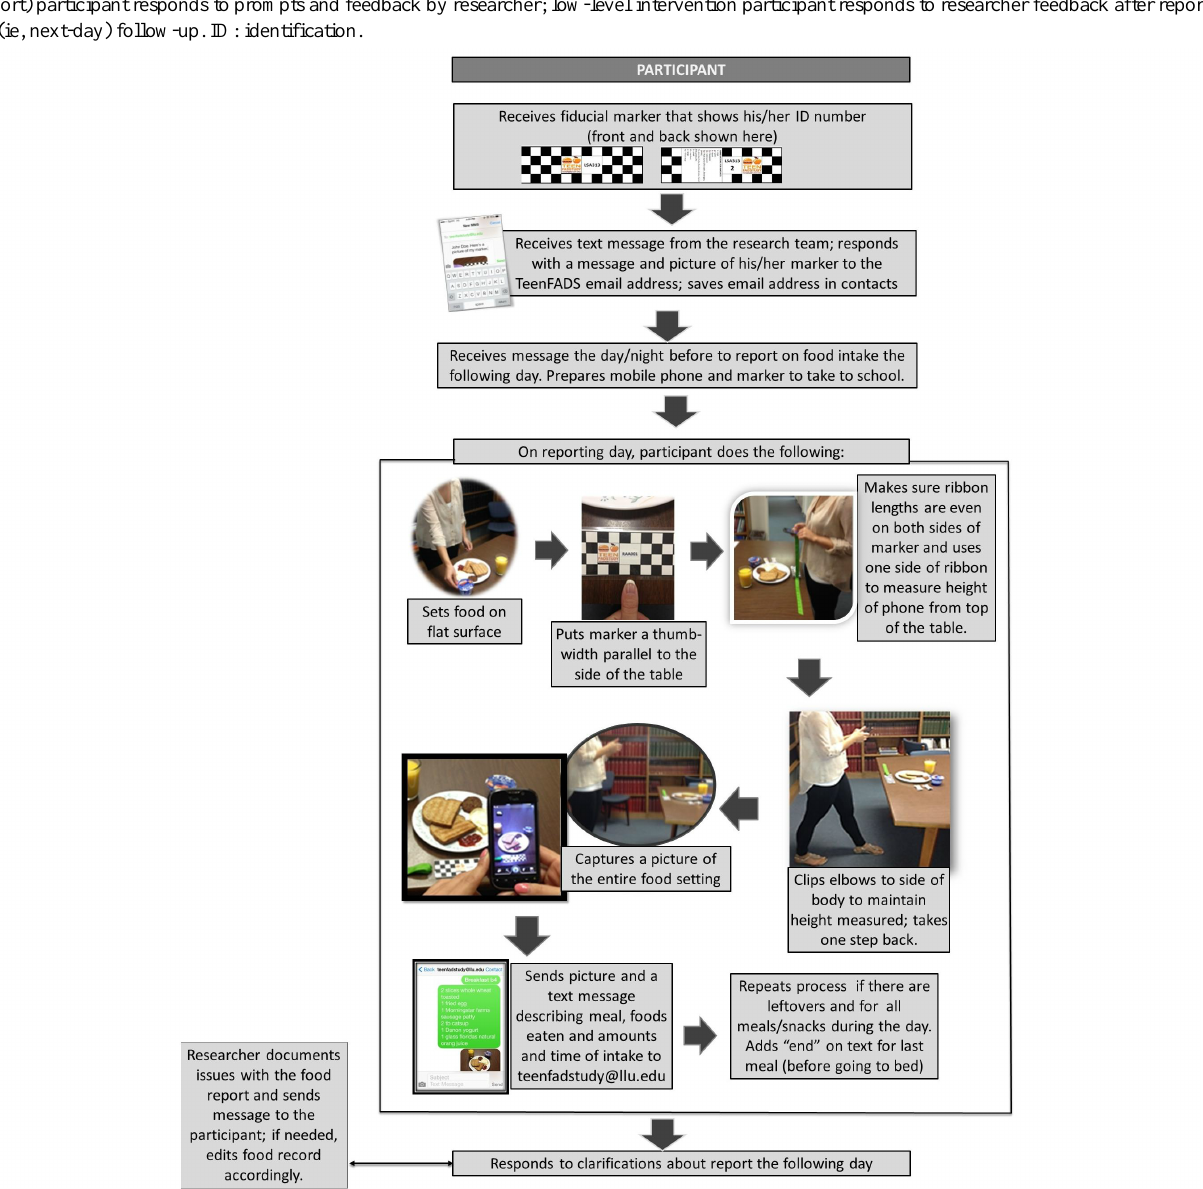
Figure 3. Diagram of the food record with digital images (FRDI) using personal mobile phones by adolescents. High-level intervention (ie, real-time support) participant responds to prompts and feedback by researcher; low-level intervention participant responds to researcher feedback after reporting day (ie, next-day) follow-up. ID: